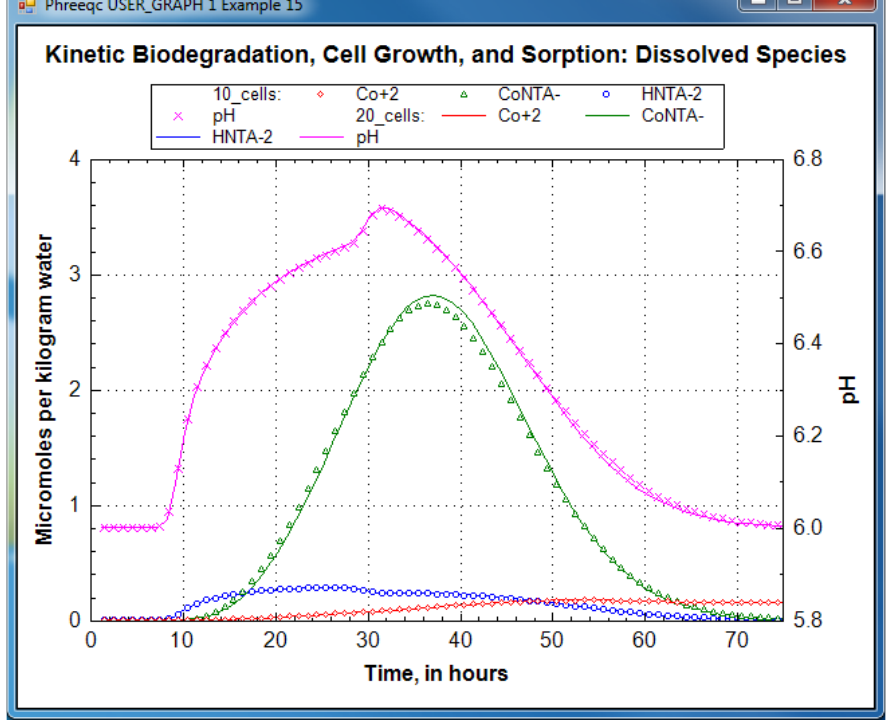
Figure 16. Dissolved concentrations and pH values at the outlet of the column for Nta and cobalt transport simulations with 10 (symbols) and 20 cells